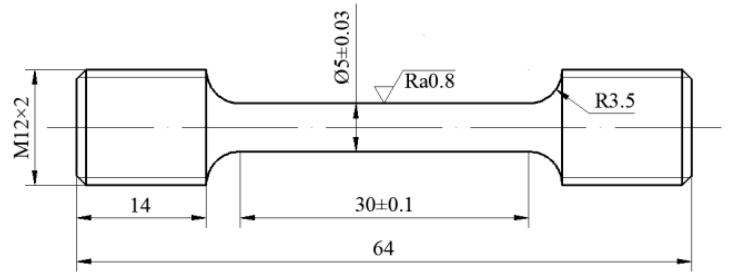
Figure 1. Specific dimensions of cylindrical tensile specimens (unit: mm). 74